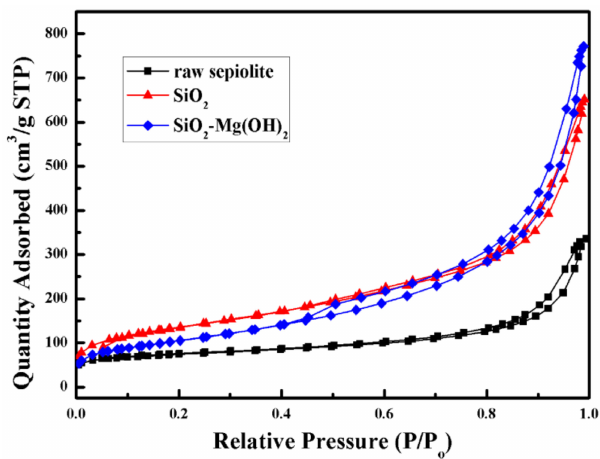
Figure 4. N 2 adsorption / desorption isotherms of raw sepiolite (black), amorphous SiO 2 nanotubes (red), and Mg(OH) 2 –SiO 2 composite